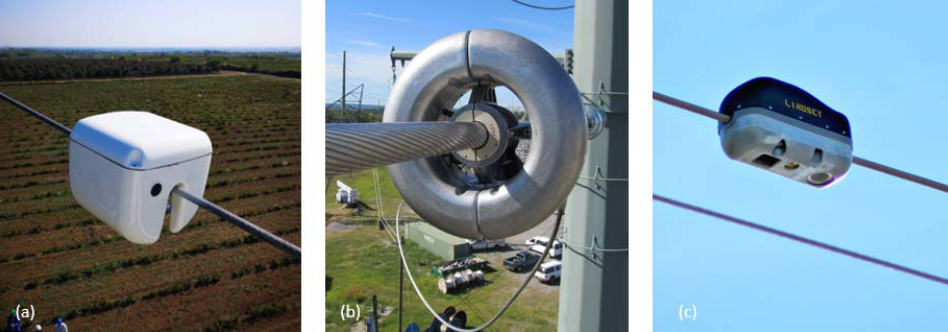
Figure 1. Direct conductor temperature measurement sensors: ( a ) Gridpulse-Base sensor [11]; ( b ) Power Donut sensor [12]; ( c ) Lindsey-TLM sensor [13].